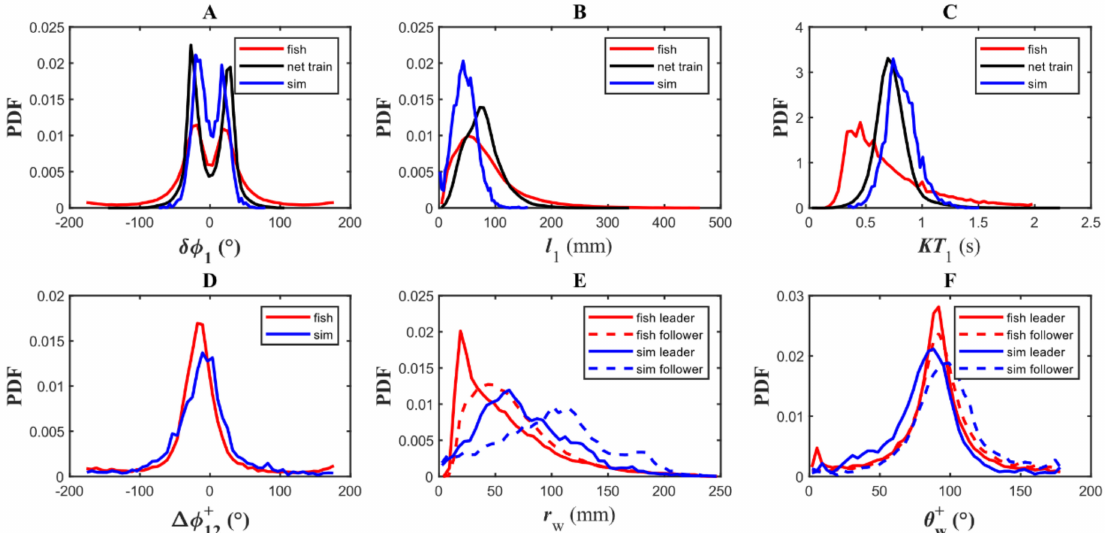
Figure 6. The comparison between the two-agent DNN model simulation and two–fish experiment. ( A ) PDF of the heading angle change after each kick of fish 1 δφ 1 ; ( B ) PDF of the distance between two kicks of fish 1 l 1 ; ( C ) PDF of the duration between two kicks of fish 1 KT 1 ; ( D ) PDF of the signed relative angle of one individual between two fish ∆ φ + ( t ) = ∆ φ × SIGN ( θ W ) ; ( E ) PDF of the distance to two fish. The solid lines represent the leaders. The dash lines 12 1 12 represent followers. r W ; ( F ) PDF of the absolute value of the relative angle to the wall for the leader and follower θ W +